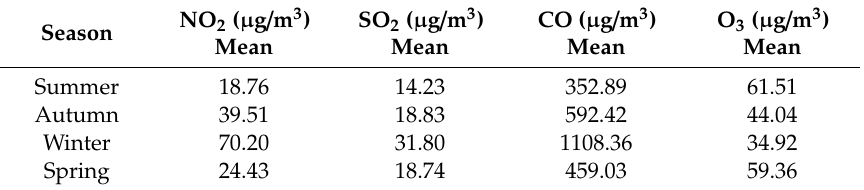
Table 4. Mean seasonal concentrations of NO 2 , SO 2, CO and O